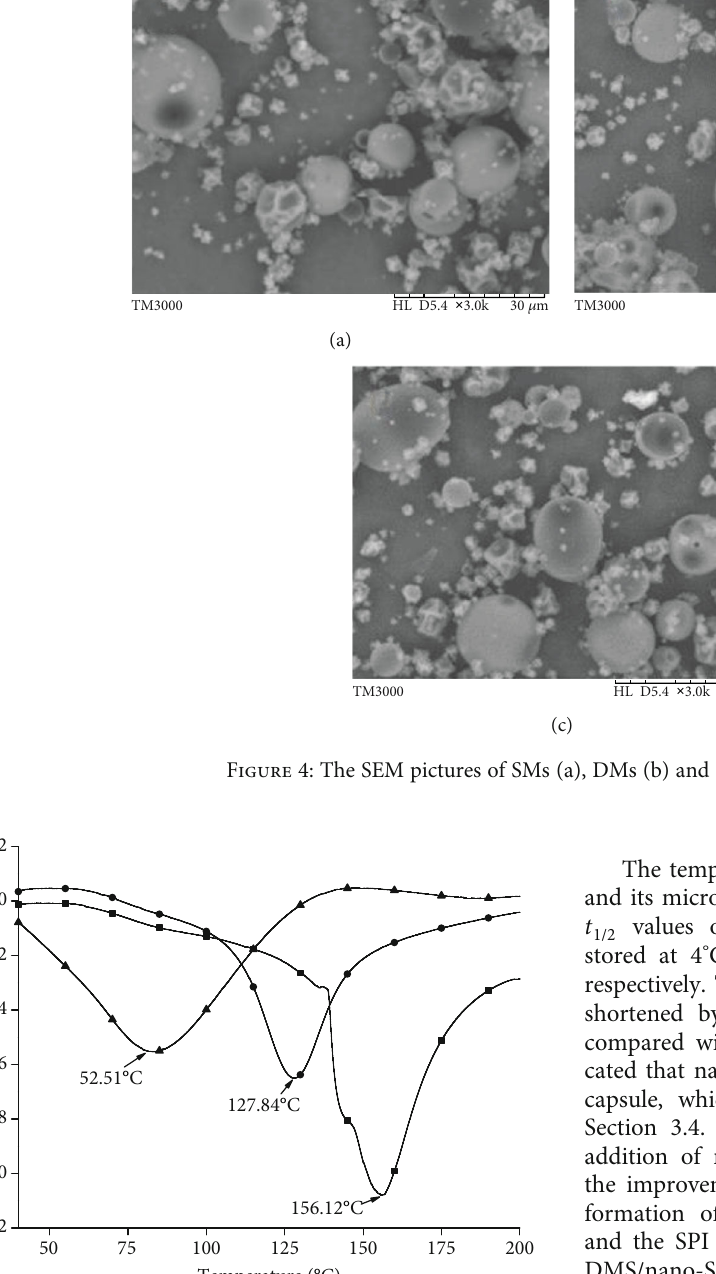
Figure 5: The DSC curves of SMs, DMs, and DMs/nano-SiO